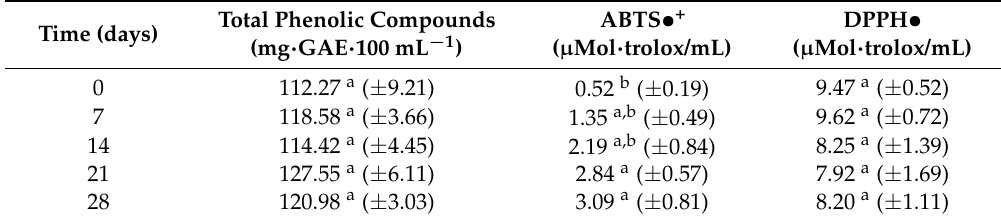
Table 2. Total phenolic compounds and antioxidant activity of blueberry and carrot blend fermented by L. reuteri during storage for 28 days at 40 ◦